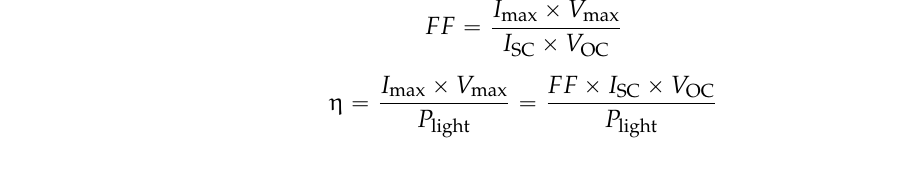
Table 4. V OC , I SC , FF , and η for DSSC calculated from Figure 10.